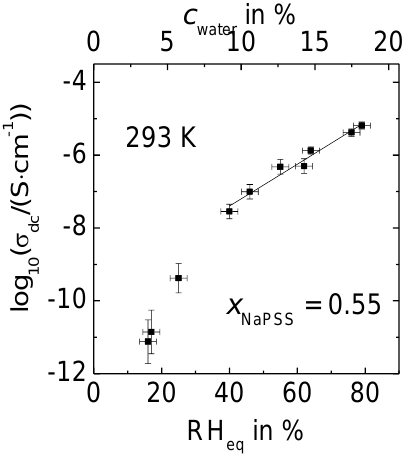
Figure 3. dc conductivities of 0.55 NaPSS∙0.45 PDADMAC determined at 293 K as a function of relative humidity (RH) eq and water content, respectively.